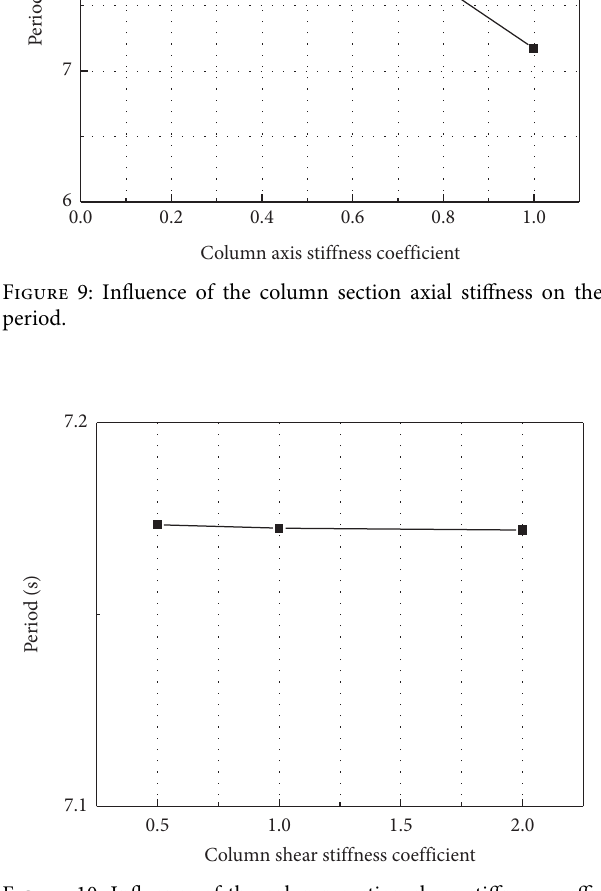
Figure 12: Influence of the beam section bending stiffness (10 − 7 ∼ 10 5 ) on the